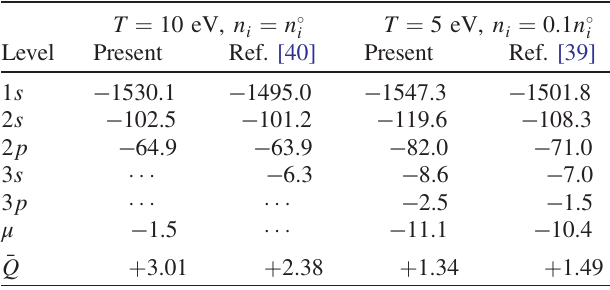
TABLE I. Electronic structure of Al metal and Al plasma. All energies in our present calculations are subtracted by ε s , in order to compare with other theoretical data. Al solid density is n ∘ i ¼ 2 . 7 g = cm 3 and ¯ Q is the average charge state. Energies are in eV.